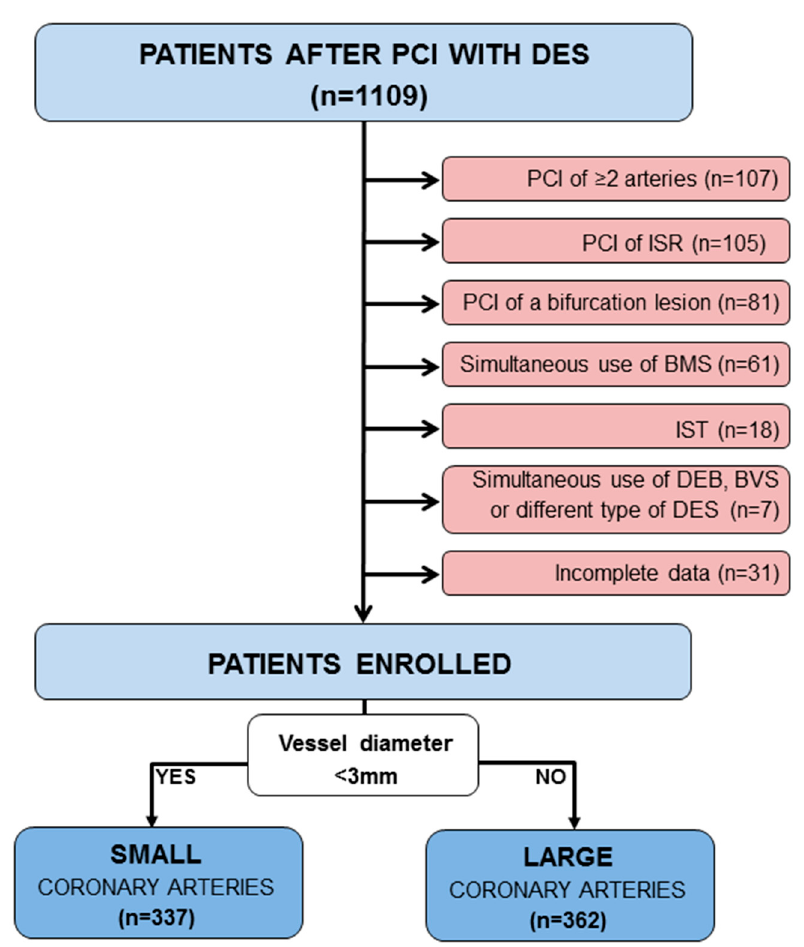
Figure 1. Study chart. ISR—in stent restenosis, IST—in stent thrombosis, BMS—bare metal stents, BVS—bioresorbable vascular scaffold, DEB—drug-eluting balloon, DES—drug-eluting stent, PCI—percutaneous coronary intervention.